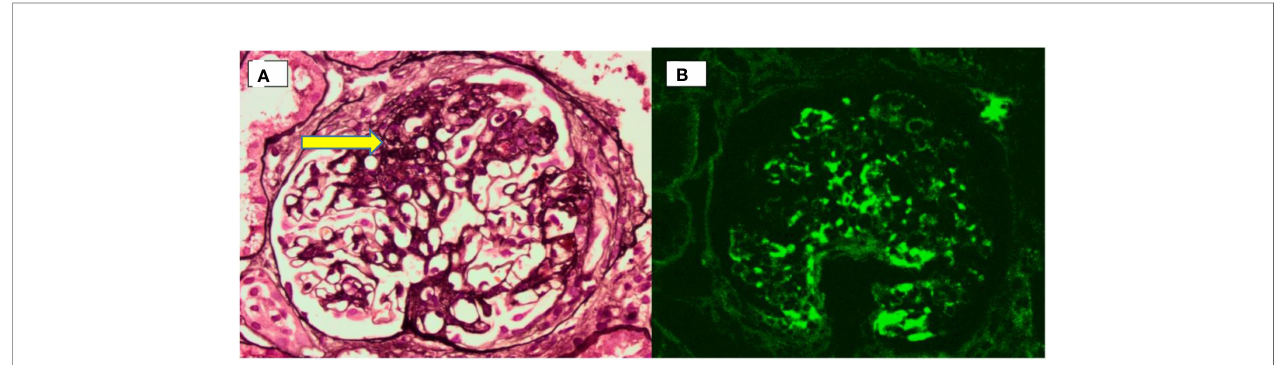
FIGURE 2 | Renal biopsy. (A) Photomicrograph showing an area of segmental sclerosis (arrow) within a glomerulus. (B) Immuno fl uorescence microscopy showing predominant mesangial IgA